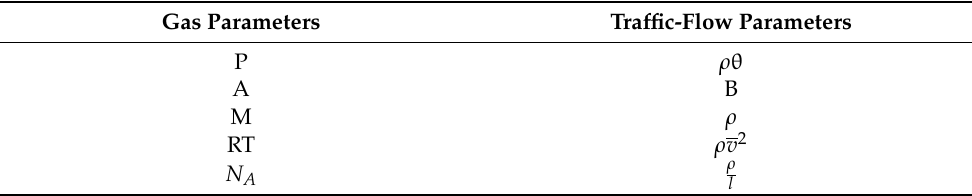
Table 1. Analogies of gas parameters with traffic